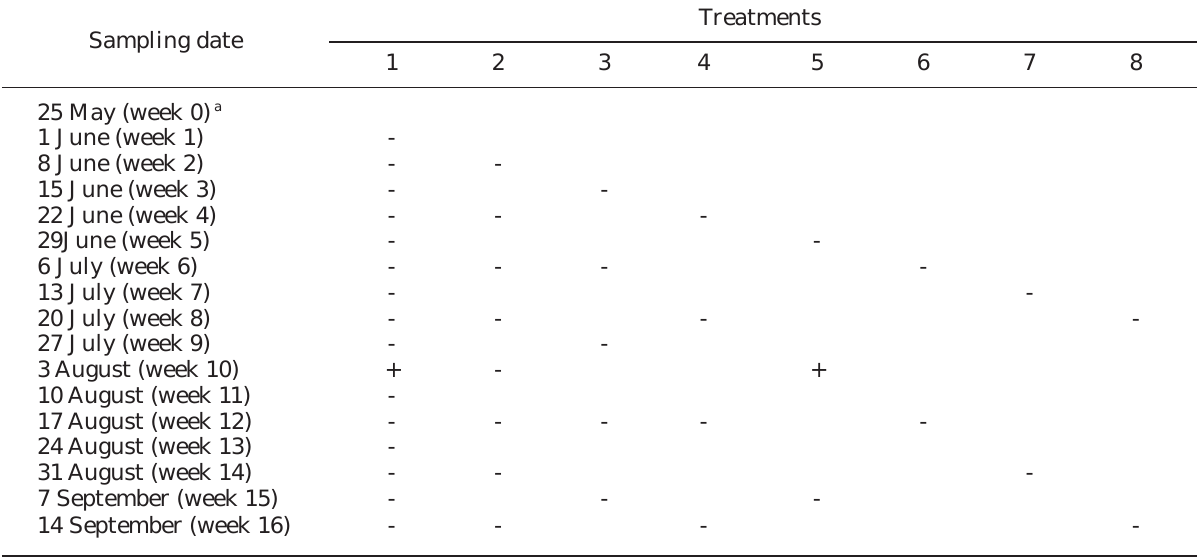
Table 1. Sampling procedure and results of the investigation on sporulation of P. chlamydospora on freshly-cut infected grapevine wood in situ . The treatments’ number, from 1 to 8, correspond to different age cut surfaces in weeks. At the time of each survey a wood slice to be examined was cut thus causing a new wound that was then left exposed for the due time for each